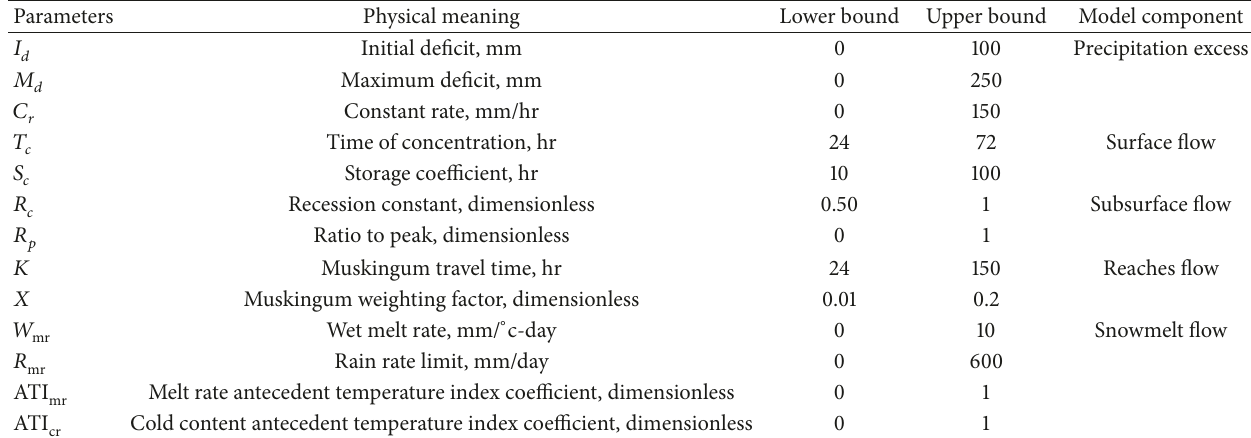
Table 3: Calibration parameters for hydrologic simulation of HEC-HMS